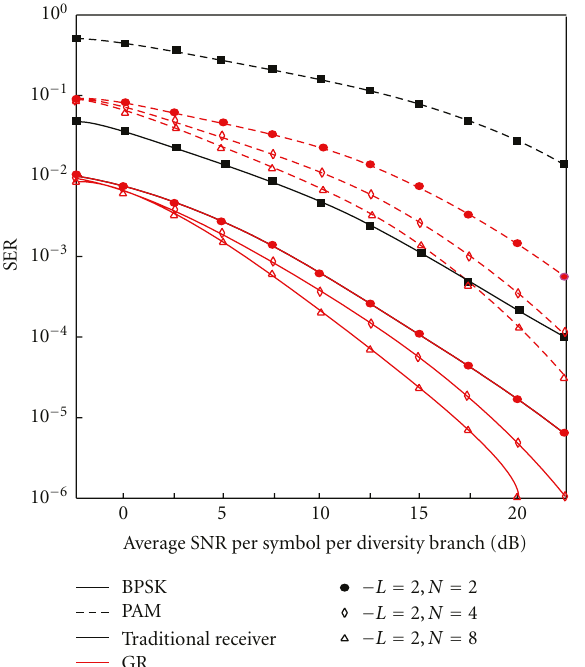
Figure 5: Comparison of the average BER of coherent BPSK and 8-PAM for GR with quadrature subbranch HS/MRC and HS/MRC schemes versus the average SNR per symbol per diversity for various values of 2 L with N =